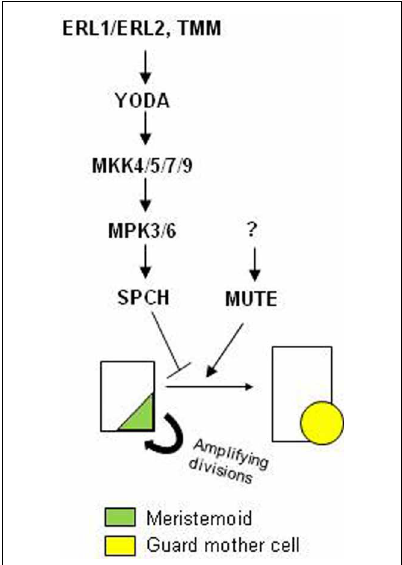
FIGURE 1 | Model for the regulation of the self-renewal behavior of the meristemoids and their transition to guard mother cell (GMC) fate. Predominance of SPCH, which is activated by YDA MAPK module, inhibits the meristemoid-to-GMC transition by promoting the self-renewal behavior of the meristemoids. In contrast, predominance of MUTE represses the amplifying divisions of the meristemoids and enhances their transition through the GMC fate. GMC symmetrically divides to produce paired-guard cells (not shown). The components upstream of MUTE remain unknown. SCRM1 and SCRM2 function in this transition through direct interaction with SPCH and MUTE (not